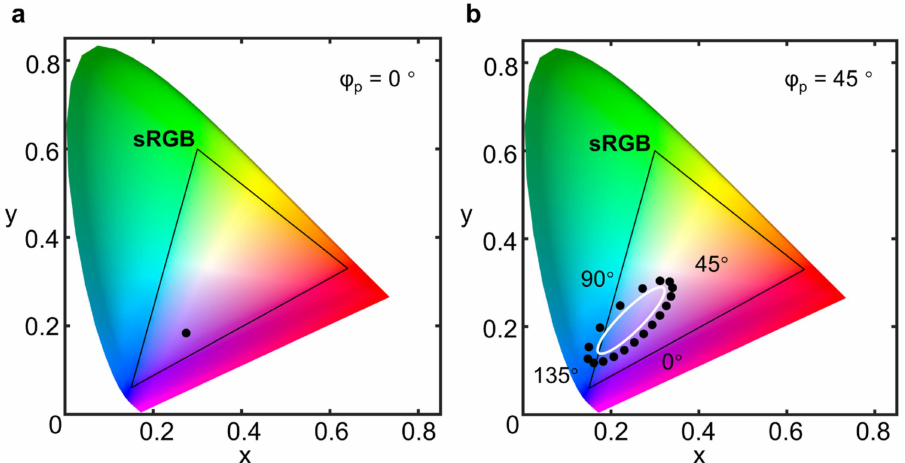
Figure 6. Corresponding CIE 1931 chromaticity coordinates of the reflection spectra in ( a ) Figure 5d and ( b ) Figure